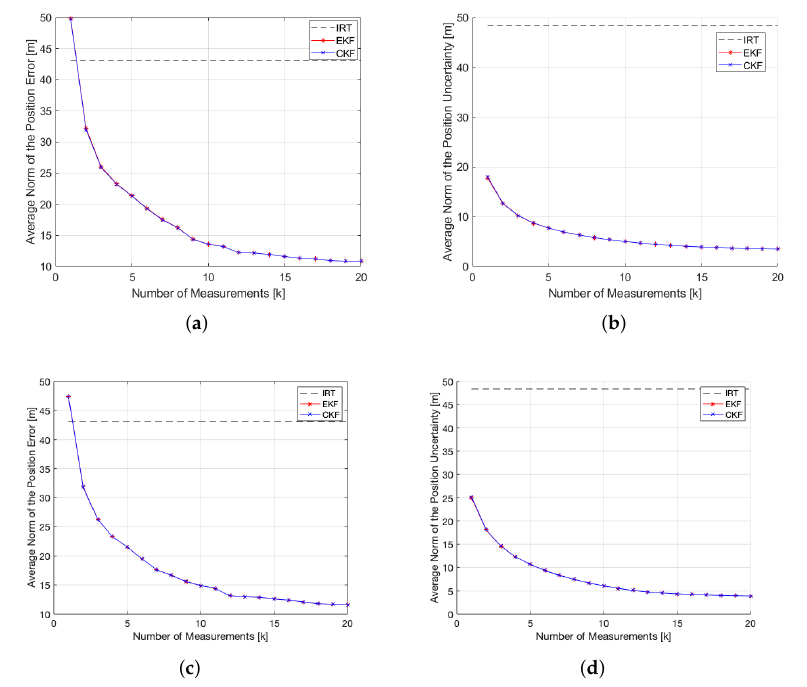
Figure 10. EKF and CKF filtering results for the flat terrain simulation. ( a ) BR-EKF and BR-CKF average norm of the position error; ( b ) BR-EKF and BR-CKF average norm of the position uncertainty; ( c ) BO-EKF and BO-CKF average norm of the position error; ( d ) BO-EKF and BO-CKF average norm of the position